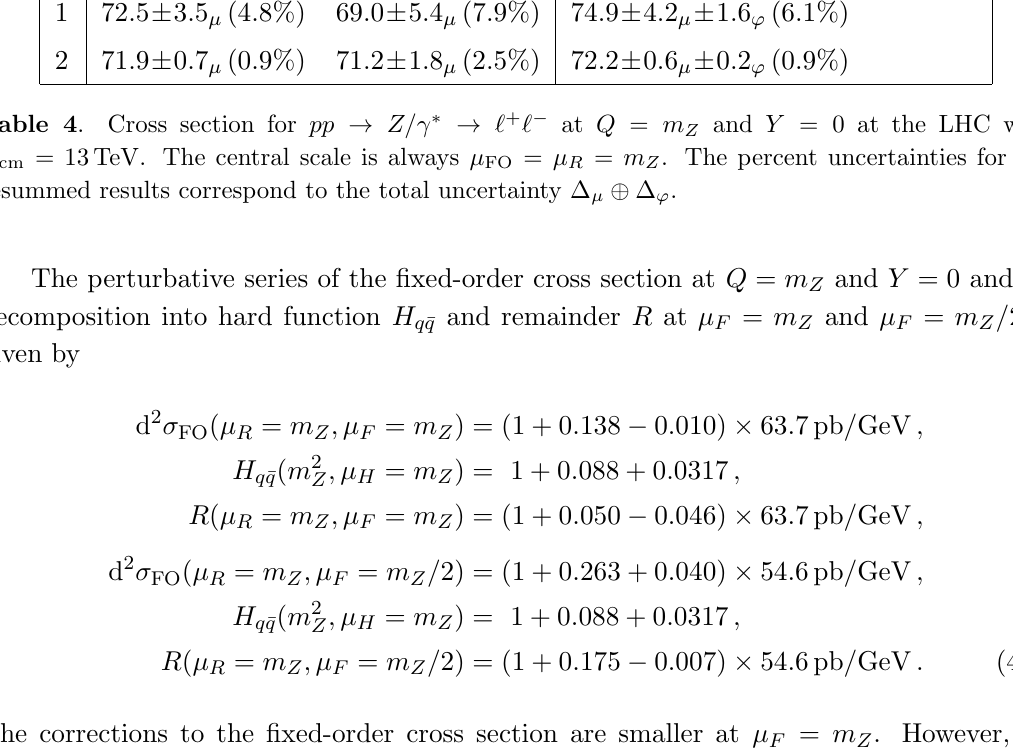
and remainder R at (cid:22) q (cid:22) q